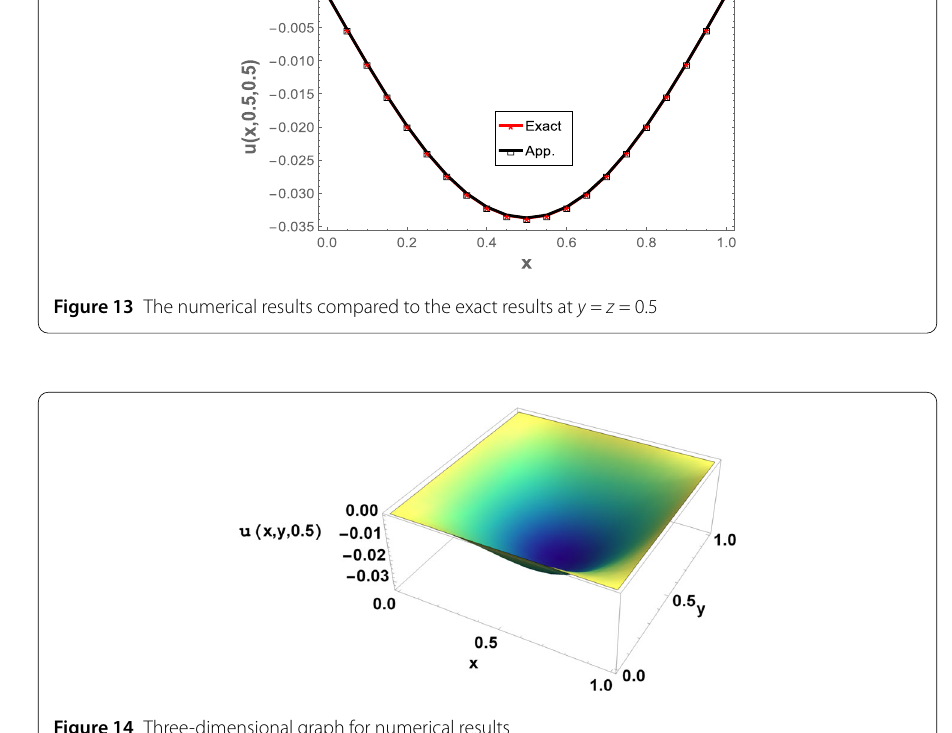
Figure 14 Three-dimensional graph for numerical